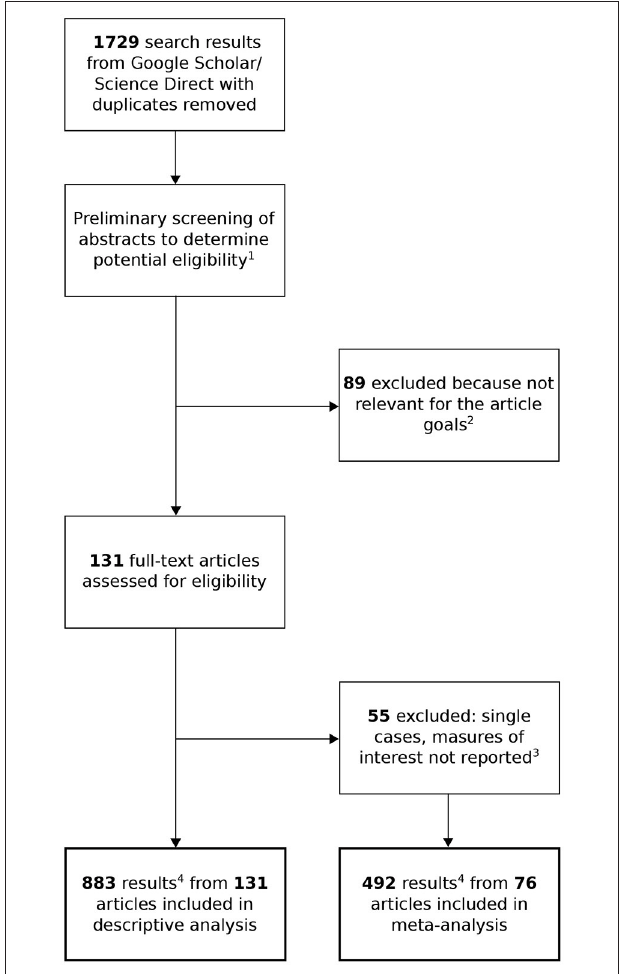
FIGURE 2 | Flow diagram for identifying articles for the meta-analysis and descriptive analysis. (1) A total of 1,503 studies were excluded because of their irrelevance (e.g., reviews, gray literature, theoretical articles, reports from cognitive experiments), (2) based on criteria (studies without motor imagery condition; other than EEG analysis), (3) and which did not provide sufficient statistics, such as means, standard deviations and size, to drive meta-analysis. (4) A majority of the articles contained results of more than one analysis. Each variant of data processing was examined as a separate result/BCI